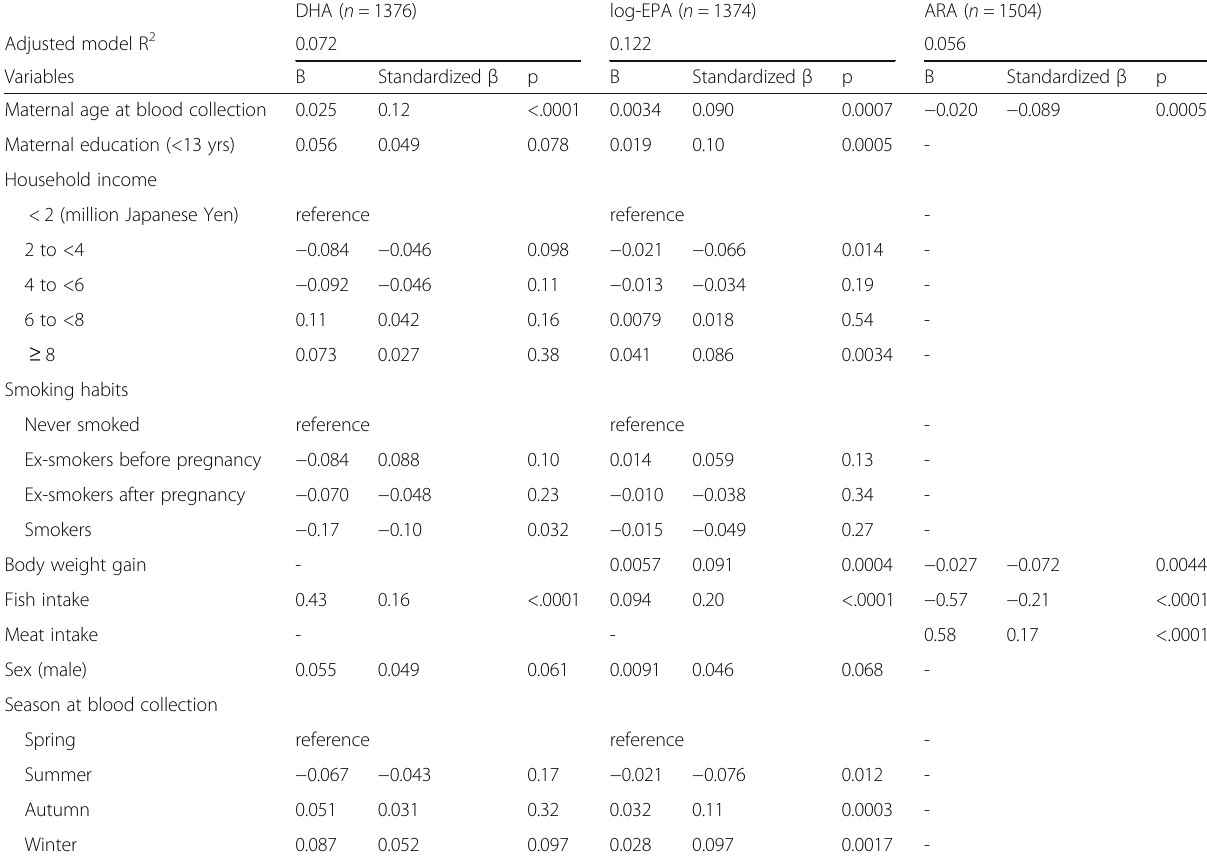
Table 5 Multiple stepwise regression analyses for determinants of PUFA levels in maternal blood